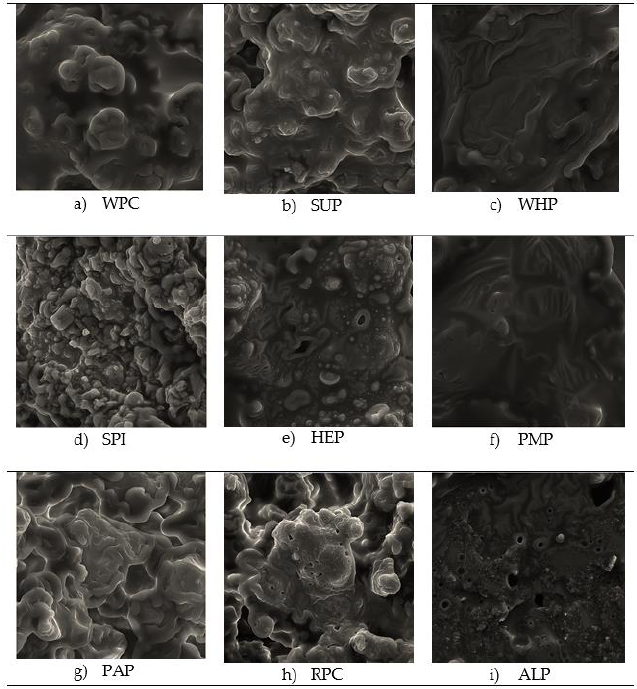
Figure 1. ( a – i ) Microstructure of high-protein bars from the scanning electron microscope (SEM HV: 30 kV, View field: 271 μm, SEM MAG: 800×).